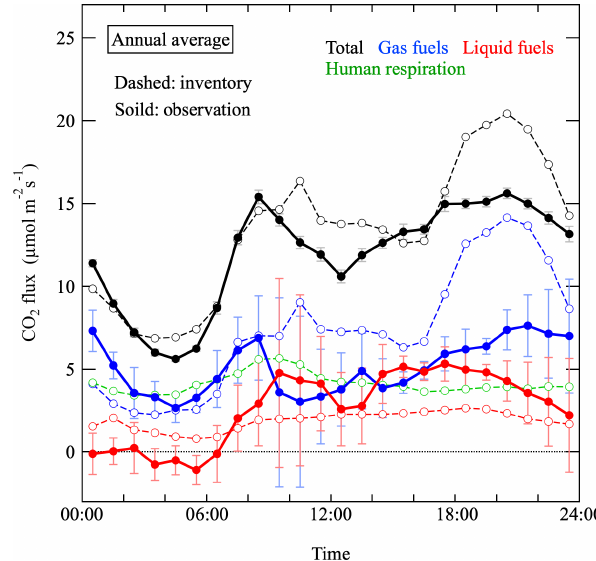
Figure 10. Same as in Fig. 9 but for the annual average diurnal cycles. The error bars for the estimated CO 2 flux from liquid fuel consumption are the standard deviations of the diurnal cycles of the flux for respective seasons from the annual average cycle, assum- ing that the actual diurnal cycles of liquid fuel consumption do not change significantly throughout the year (see